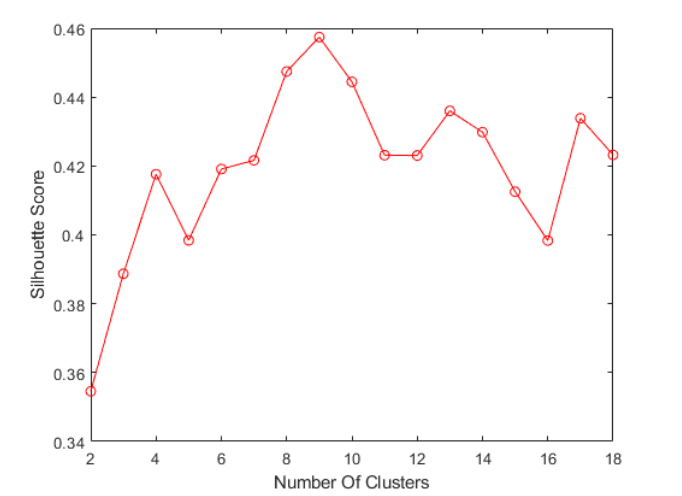
Figure 3. Silhouette coefficient versus the number of